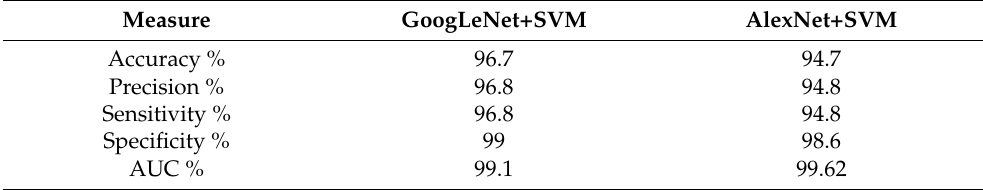
Table 6. The results of the hybrid method on the lower GI dataset.